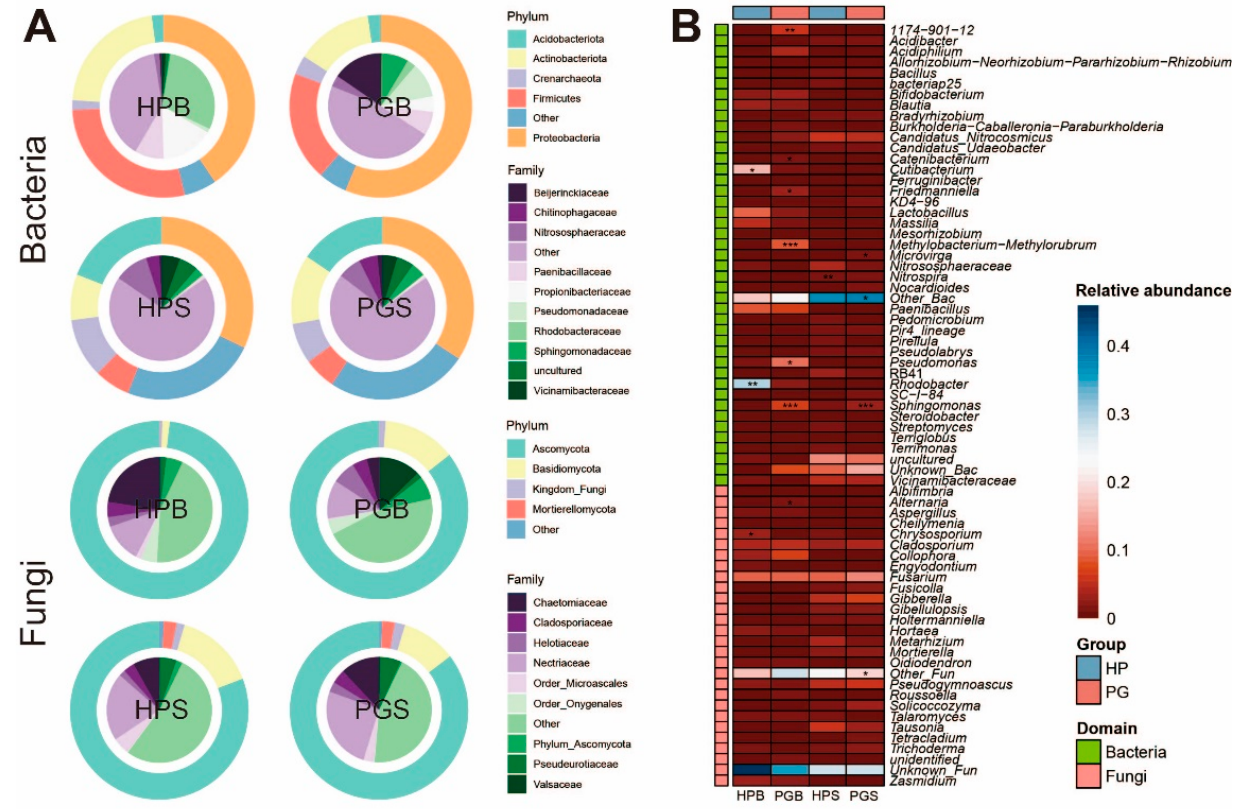
Figure 2. Microbial taxonomic composition of each group. ( A ) Combined donut and pie charts in- dicate phylum and family, respectively. ( B ) Heatmap showing the difference in microbial abun- dance at the genus level, either between bark (HPB and PGB) or soil (HPS and PGS). Mann–Whitney U tests were applied to assess statistical significance. * p < 0.05, ** p < 0.01, *** p <